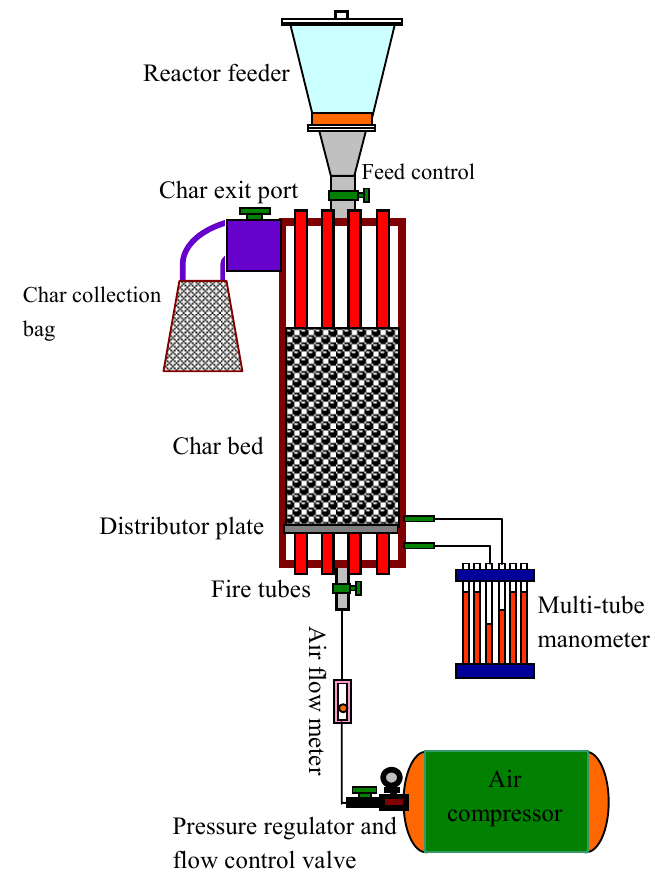
Fig. 2: Schematic diagram of a cold model fixed-bed fire-tube heating